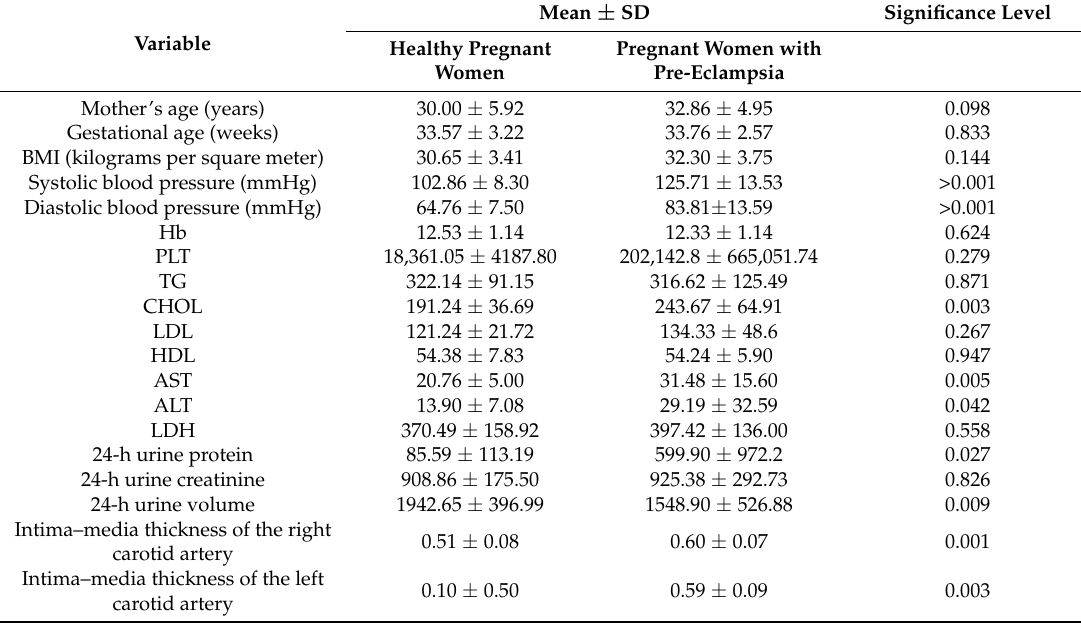
Table 3. Basic characteristics of healthy pregnant women and pregnant women with pre-eclampsia in terms of mean and standard